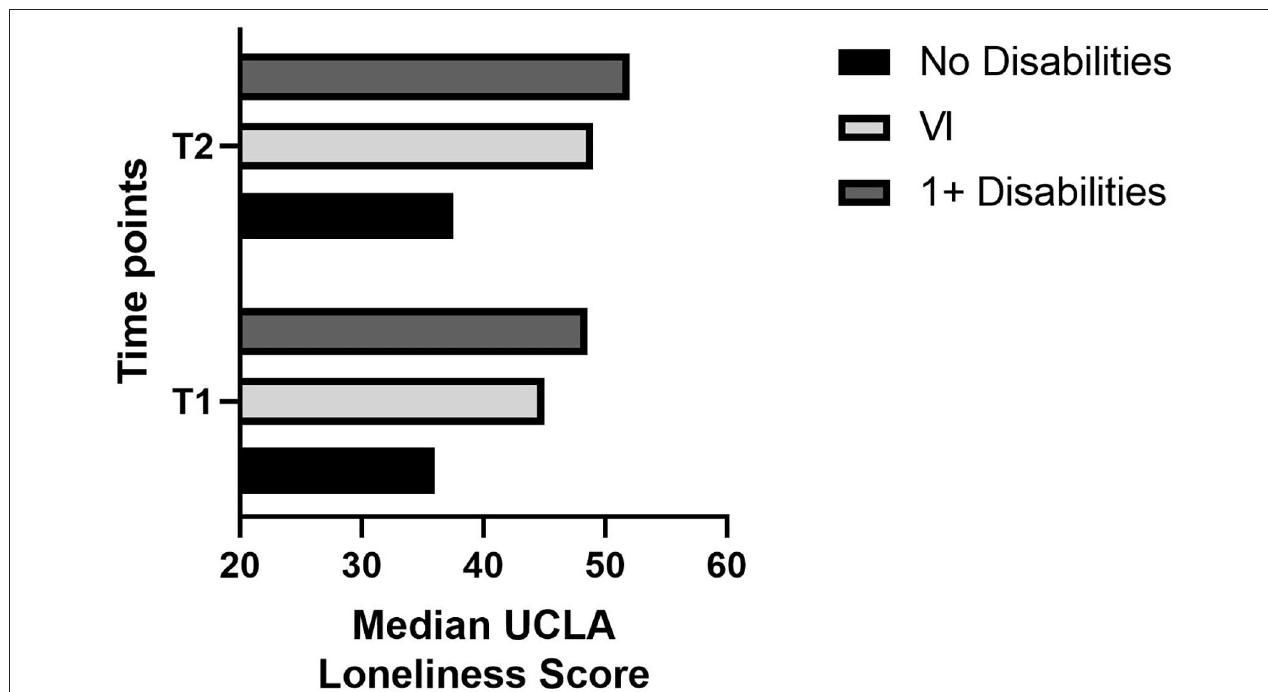
FIGURE 1 | Median UCLA loneliness score by subgroup at T1 and